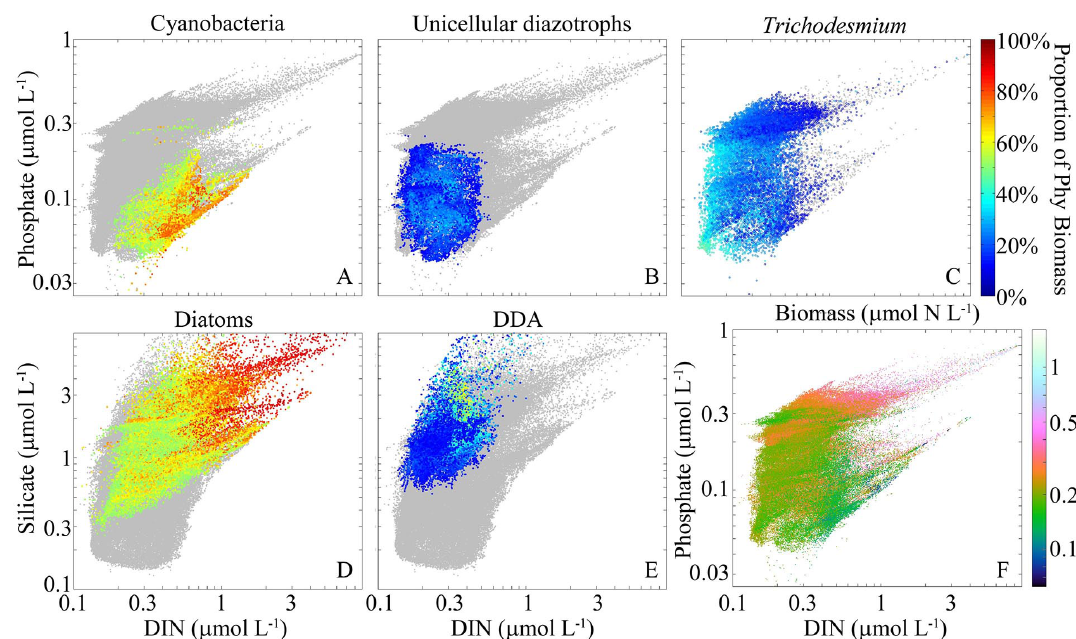
Figure 12. Phytoplankton taxa relation to nutrients – Panels (A, B, C, D, E) show the proportion of surface phytoplankton biomass comprised by cyanobactiera, unicellular microbial diazotrophs, Trichodesmium , diatoms, and diatom-diazotroph assemblages, respectively. In panels (A, B) , and (C) phytoplankton proportion is plotted as a function of phosphate ( y axis) and dissolved inorganic nitrogen ( x axis). In panels D and E, phosphate is replaced by silicate (limiting nutrient for diatom taxa). For non-diazotrophic taxa (A, D) proportions of biomass are plotted when the taxa’s proportion of biomass exceeds 50%. For diazotrophs (B, C, E) proportions are plotted when they exceed 10%. In all plots, gray values show the full extent of the model’s realized nutrient-space . Panel F shows total phytoplankton biomass (µmol N L − 1 ) in the model as a function of DIN and phosphate. All plots are surface plots of values from model year